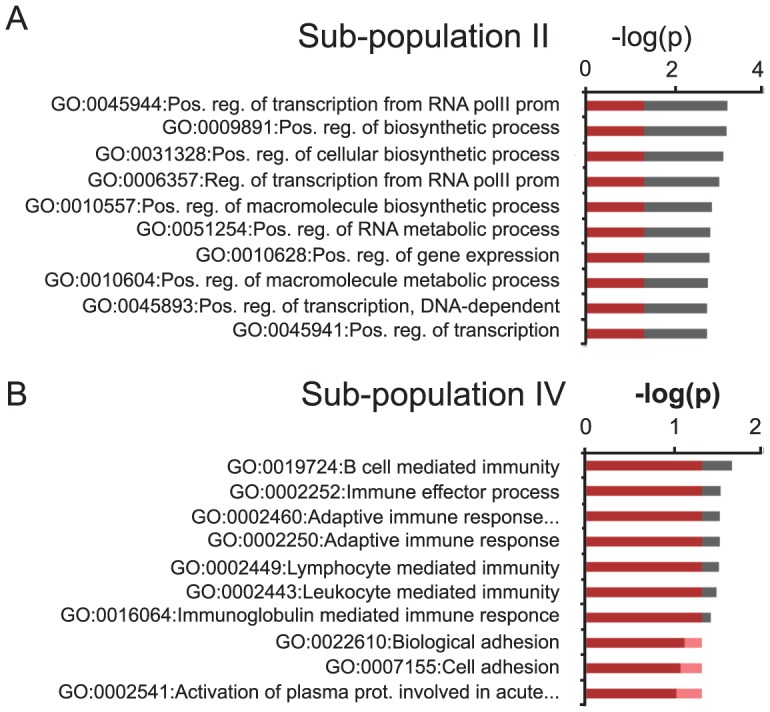
GO-analysis of specific subgroups.A–B) GO-terms of significantly up-regulated H3K27me3 and H3K27me3S28p positive transcripts in the sub-populations indicated with roman numerals II (A) and IV (B) in Figure 3G and H. Values on the axis are −log(p-values) of the most significant GO-terms (Benjamini-Hochberg corrected for multiple testing). Red coloring covers the values below 0.05 (approximately −1.3 when log10 transformed). For GO-terms of all subgroups I–VI, please see Figure S4.